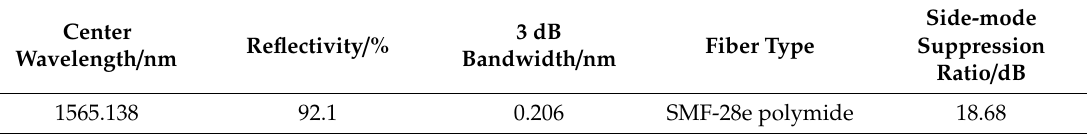
Table 1. Parameters of FBG sensors.